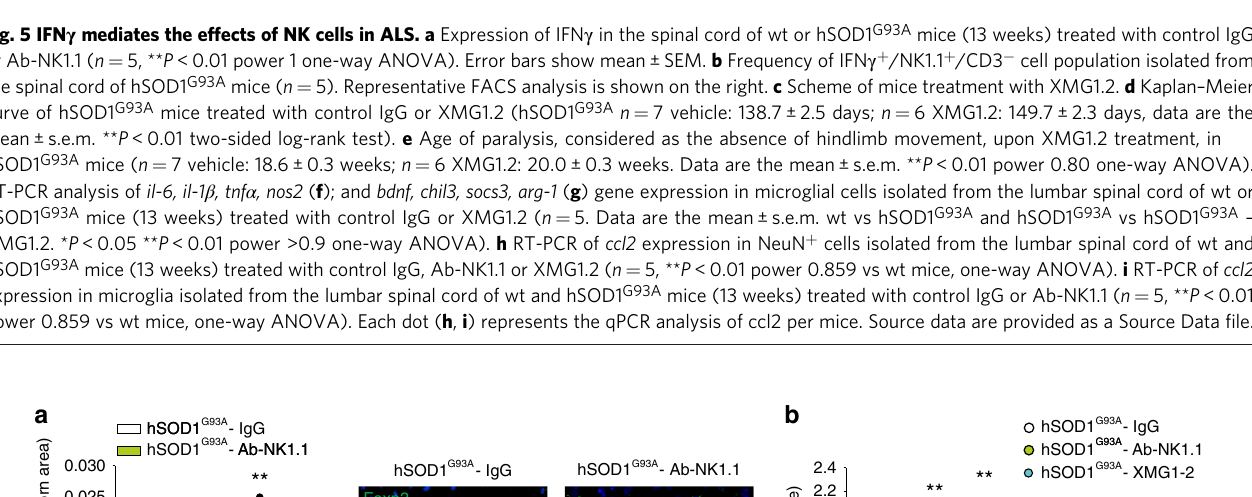
Fig. 5 IFN γ mediates the effects of NK cells in ALS. a Expression of IFN γ in the spinal cord of wt or hSOD1 G93A mice (13 weeks) treated with control IgG or Ab-NK1.1 ( n = 5, ** P < 0.01 power 1 one-way ANOVA). Error bars show mean ± SEM. b Frequency of IFN γ + /NK1.1 + /CD3 − cell population isolated from the spinal cord of hSOD1 G93A mice ( n = 5). Representative FACS analysis is shown on the right. c Scheme of mice treatment with XMG1.2. d Kaplan – Meier